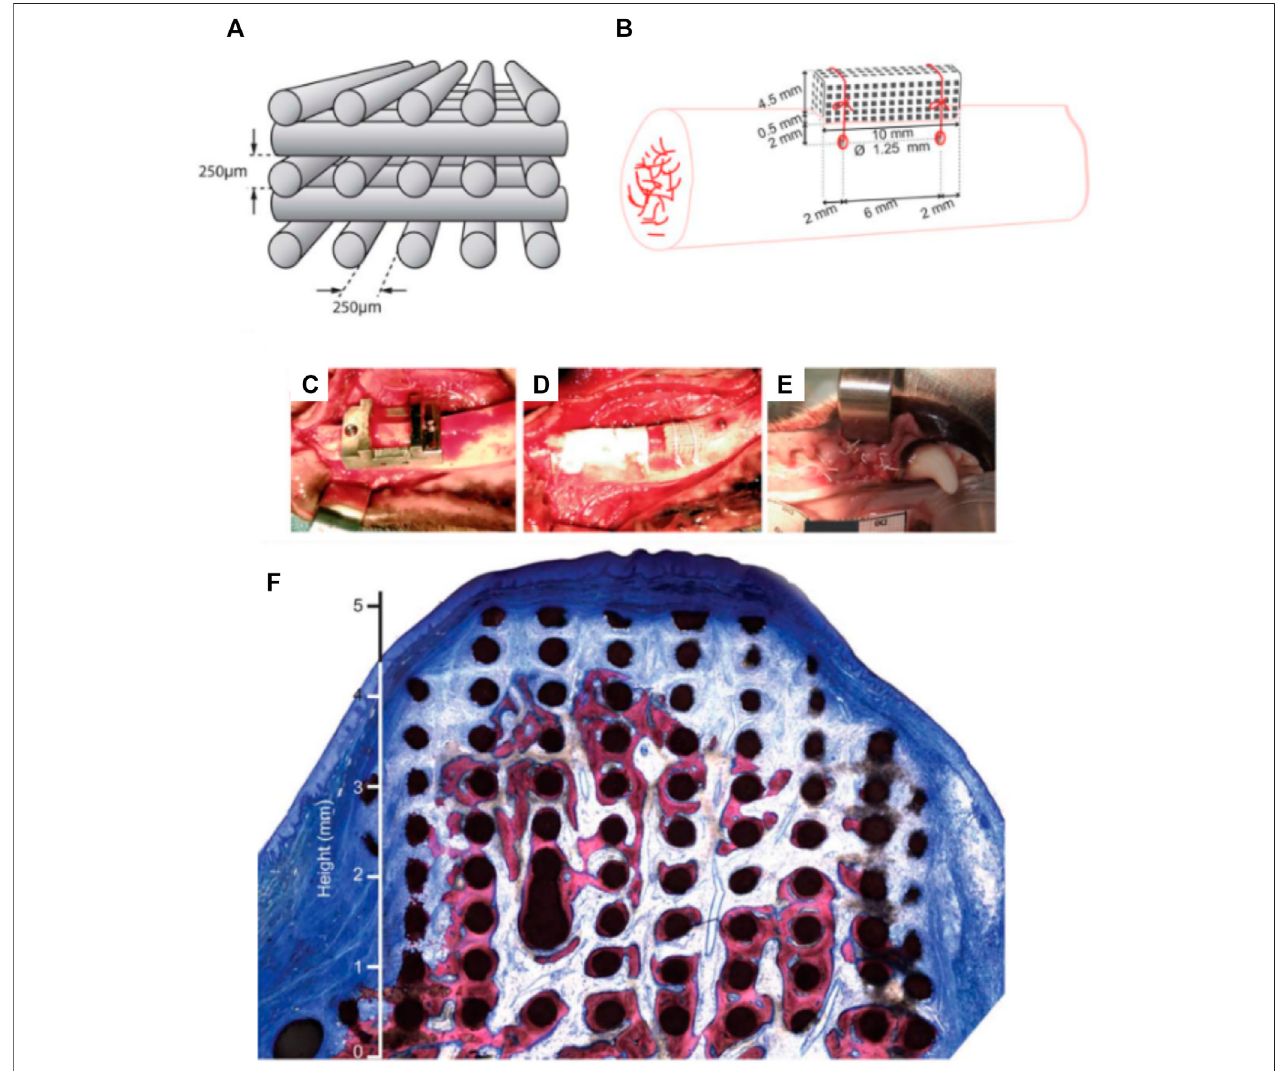
FIGURE 5 | 3D-printed bio-ceramic scaffold manufactured by a direct printing method. (A,B) : Schematic description of the scaffold porosity and dimensions, as well as the implantation in a canine model. (C – E) : Implantation of the 3D-printed scaffold and coverage by a collagen membrane. (F) : histology of the vertically augmented bone 8 weeks post-implantation. Reproduced with permission from (Carrel et al., 2016a).